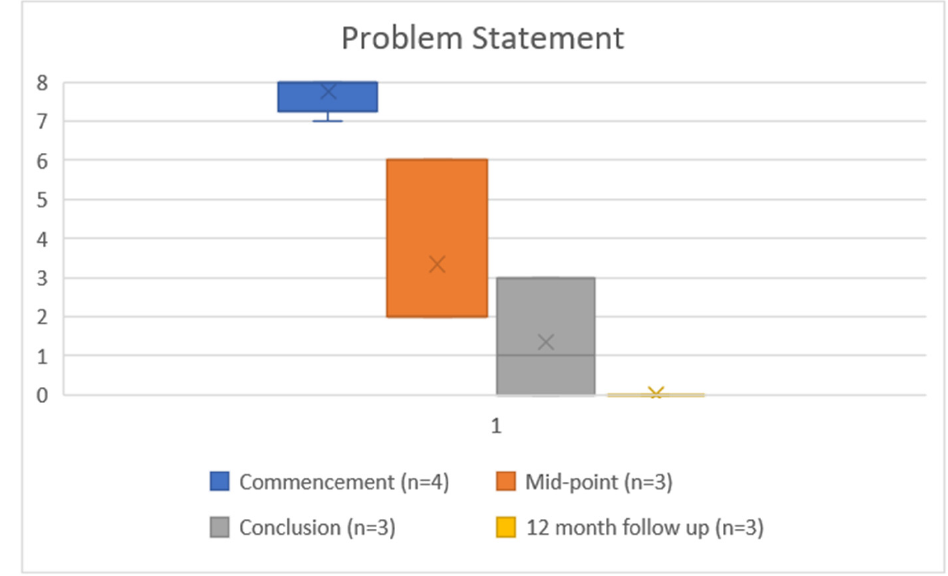
Figure 3. Problem Statement, where 0 = easiest problem to manage, 8 = most difficult problem to manage.